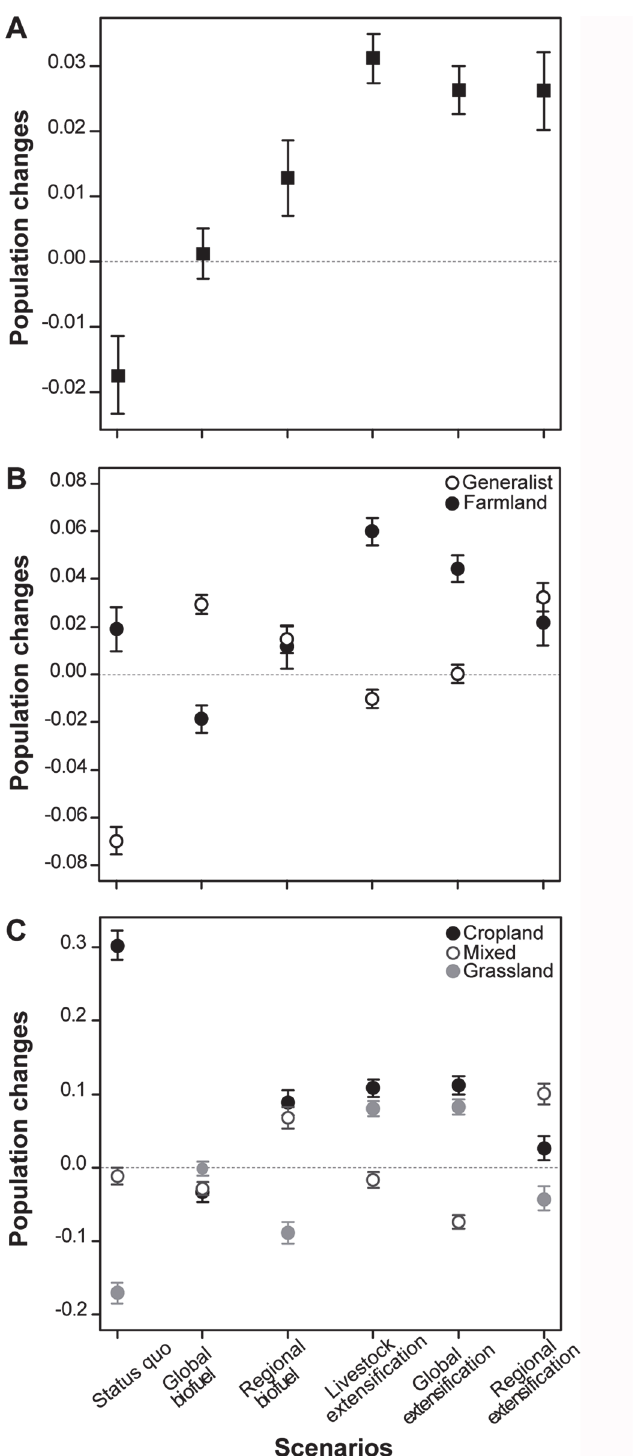
Fig 3. Predicted responses of bird populations to each farmland cover scenario. Mean ( ± SD) changes in regional abundance of A) all bird populations, B) farmland and generalist bird populations and C) grassland, cropland and mixed (grassland/cropland) bird populations according to each scenario of farmland cover changes (all combined to climate and land use change scenarios). Mean population changes correspond to the average of the changes in species regional abundance weighted by the ratio of the area